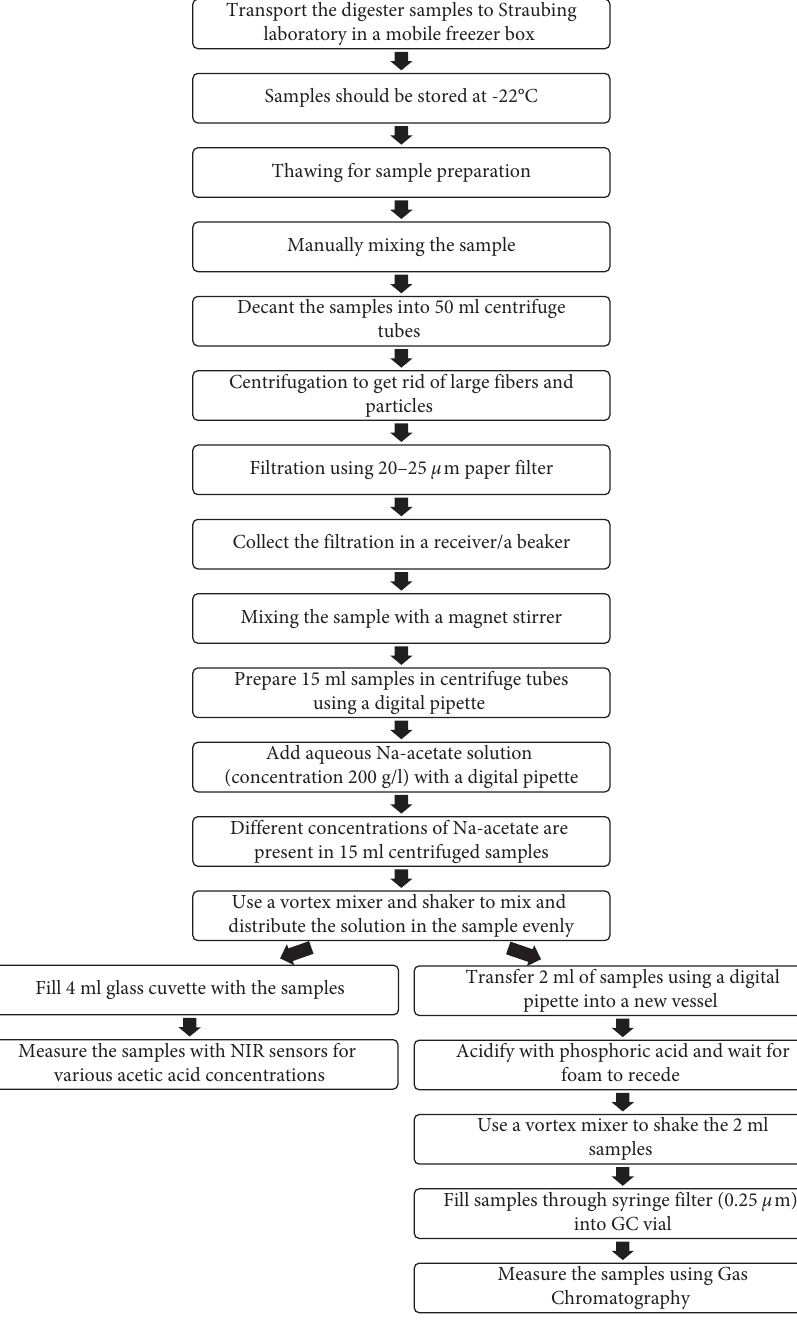
Figure 1: Detailed steps for preparing the the gas chromatography. Analyzing the two lines, it is clear Te magenta line with yellow markers represents the that they are highly correlated. Tis result guided the theoretically calculated acetic acid concentration of the preparation of 264 samples for the frst calibration of the samples, and the green line with blue markers represents NIR sensors. Tese samples consisted of the following: the measured acetic acid concentration of the samples from